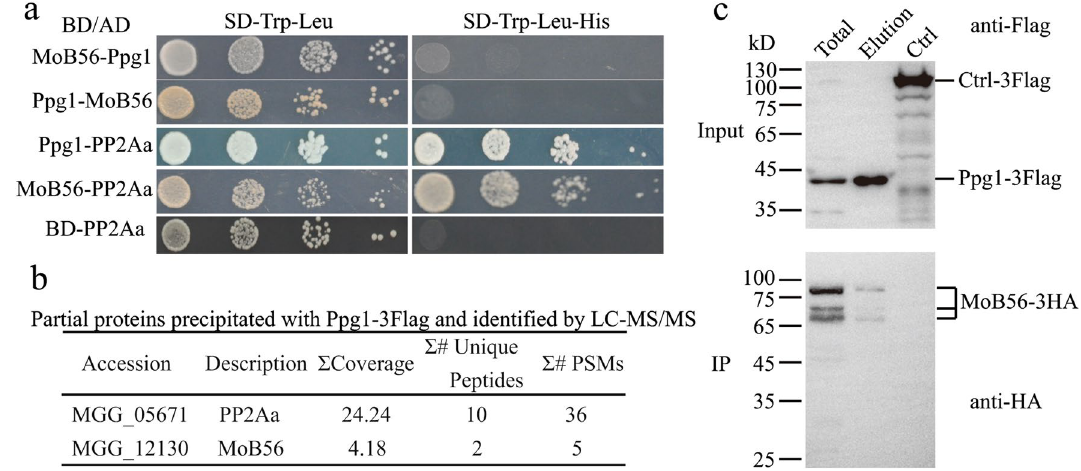
Fig. 6 Interaction assay of MoB56 with the scaffold subunit A and catalytic subunit Ppg1. a Yeast two‑hybrid analysis of the interaction between regulatory subunit MoB56, catalytic subunit Ppg1 and scaffold subunit PP2Aa. MoB56, Ppg1 and PP2Aa were inserted into vector pGADT7 and/ or pGBKT7. BD‑MoB56 and AD‑Ppg1, BD‑Ppg1 and AD‑MoB56, BD‑Ppg1 and AD‑PP2Aa, BD‑MoB56 and AD‑PP2Aa were co‑introduced into yeast Y2HGold strain, respectively, and then incubated on SD‑Leu‑Trp (as control) and SD‑Leu‑Trp‑His (for selection) for 3–5 days. b Partial proteins precipitated with Ppg1‑3Flag and identified by LC‑MS/MS. c Co‑immunoprecipitation assay shows that MoB56‑3HA interacts with Ppg1‑3Flag. A nuclear protein (predicted 85 kDa) fused 3Flag tag protein construct was used as a